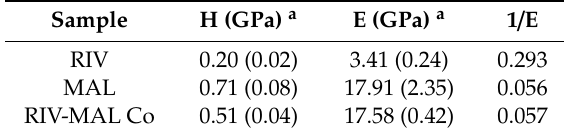
Table 2. Elastic modulus (E), mechanical hardness H, and 1 / E values for crystal samples. Sample